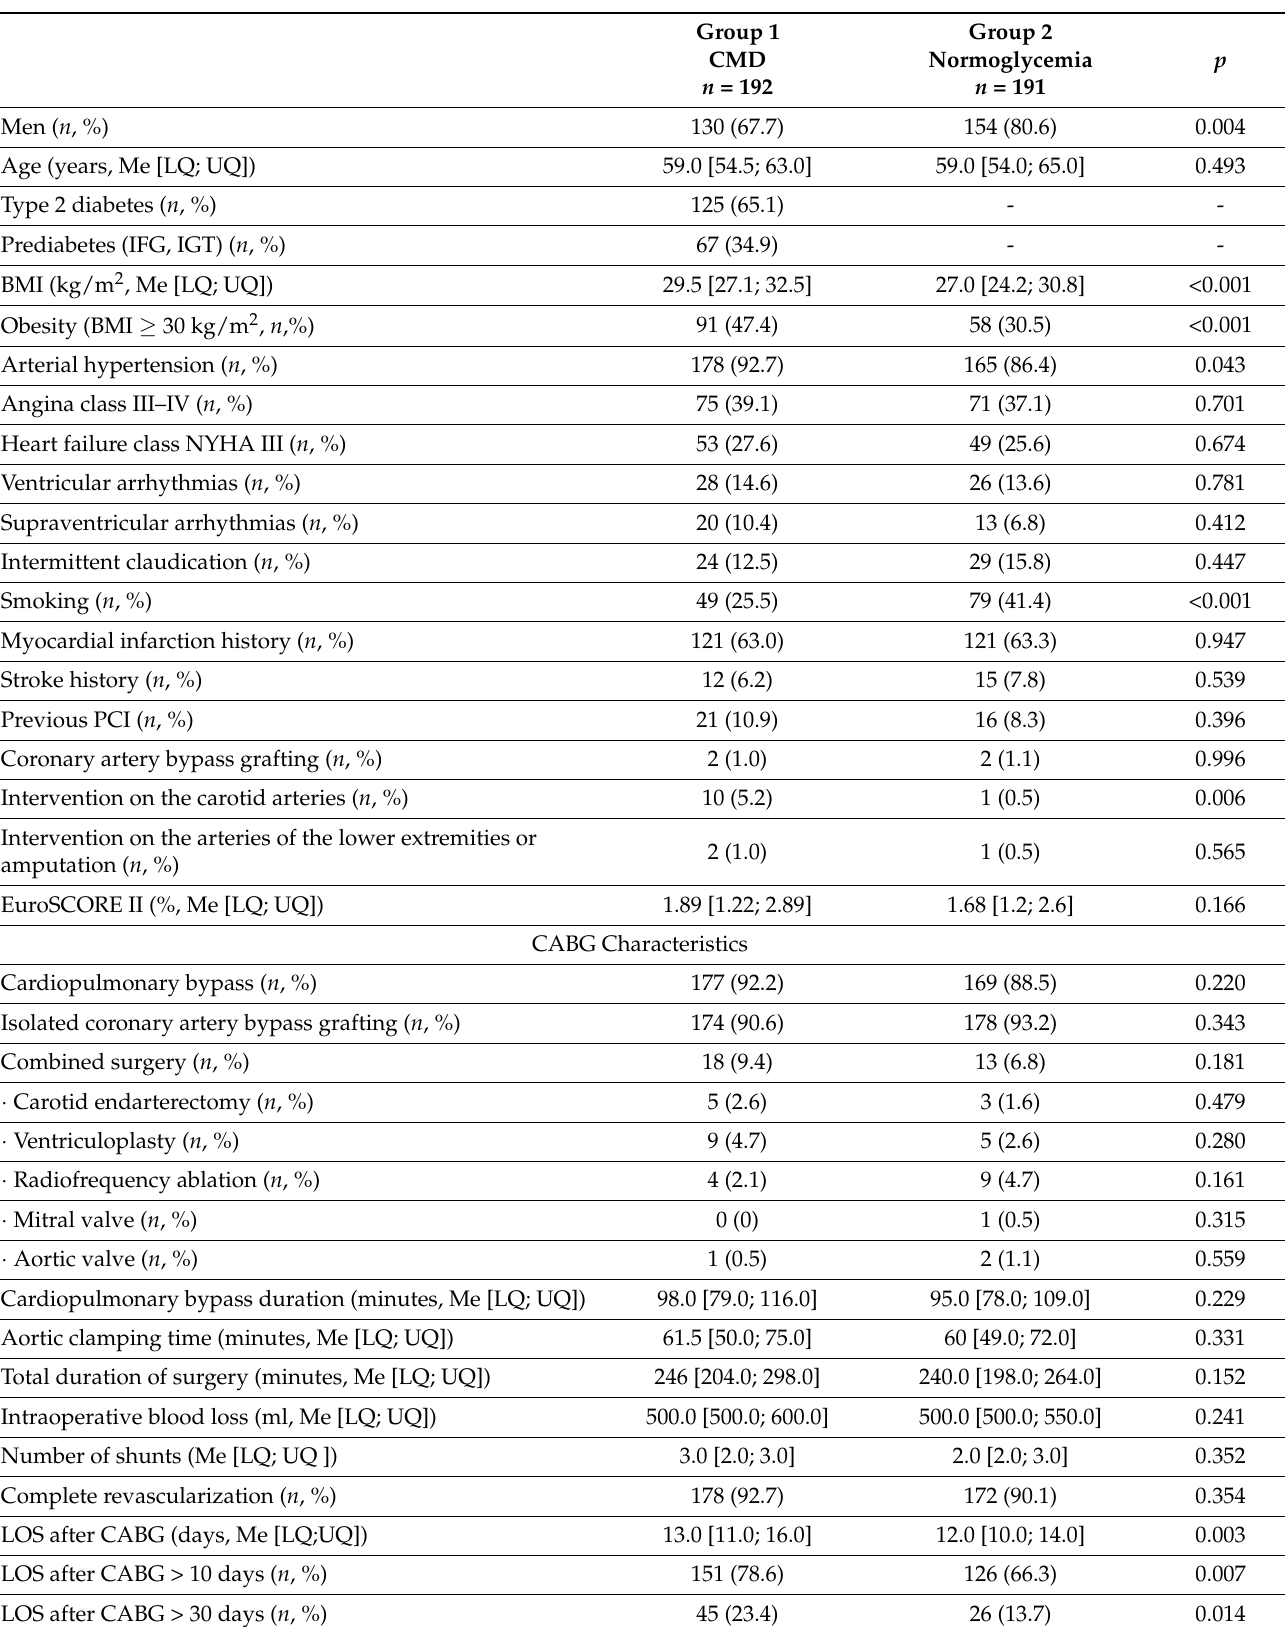
Table 1. Anamnestic and clinical characteristics of